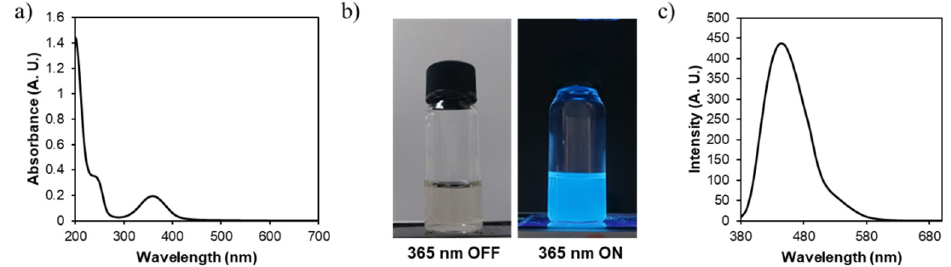
Figure 3. ( a ) UV-visible absorption spectrum, ( b ) optical and fluorescence ( λ Ex = 365 nm) images, and ( c ) emission spectrum of NGQDs ( λ Ex = 360 nm).